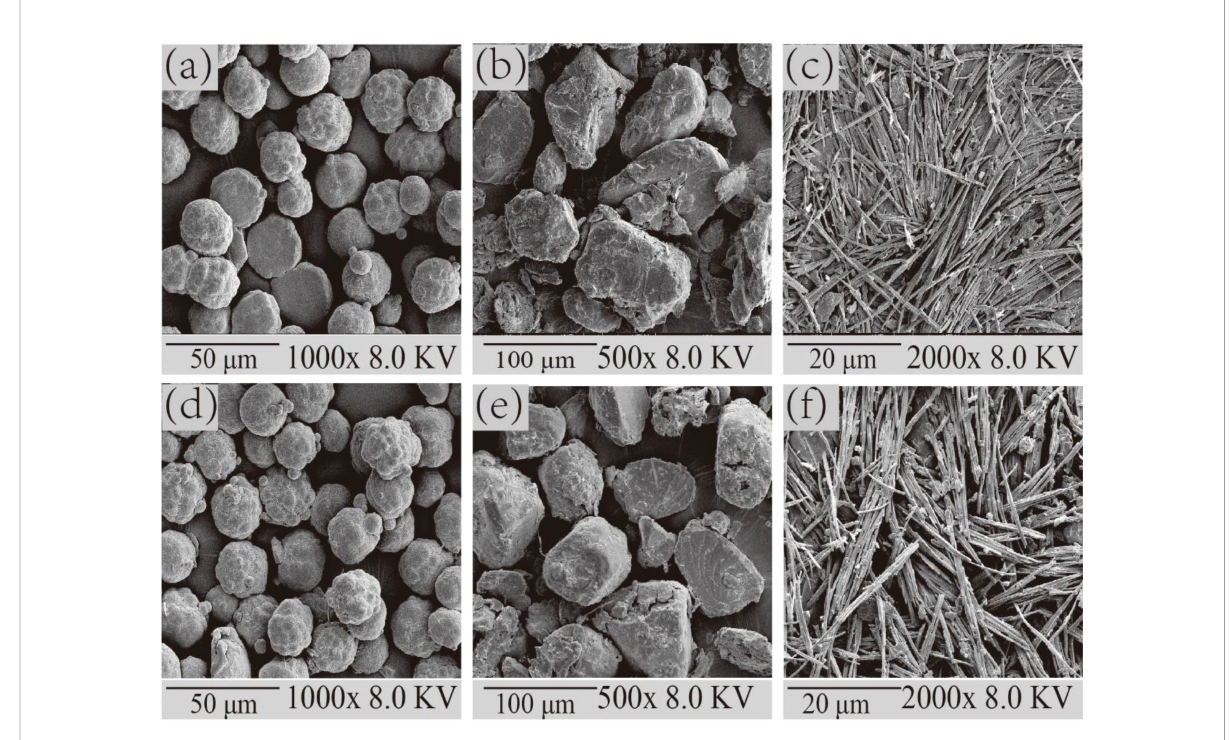
FIGURE 3 Scanning electron microscopy (SEM) images. Before adsorption (A) PE, (B) PS and (C) PP; after adsorption (D) PE, (E) PS and (F)